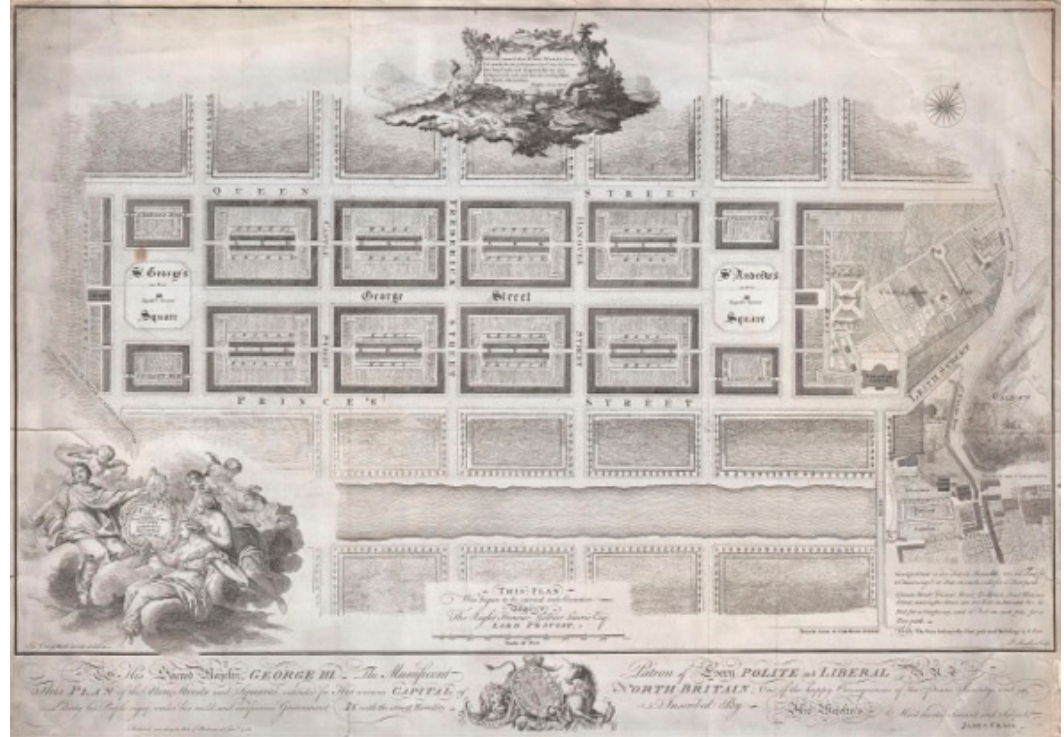
Figure 2. James Craig: Plan of the new streets and squares, intended for his ancient capital of North-Britain, 1768. Source: National Library of Scotland. https://maps.nls.uk/towns/rec/1025.